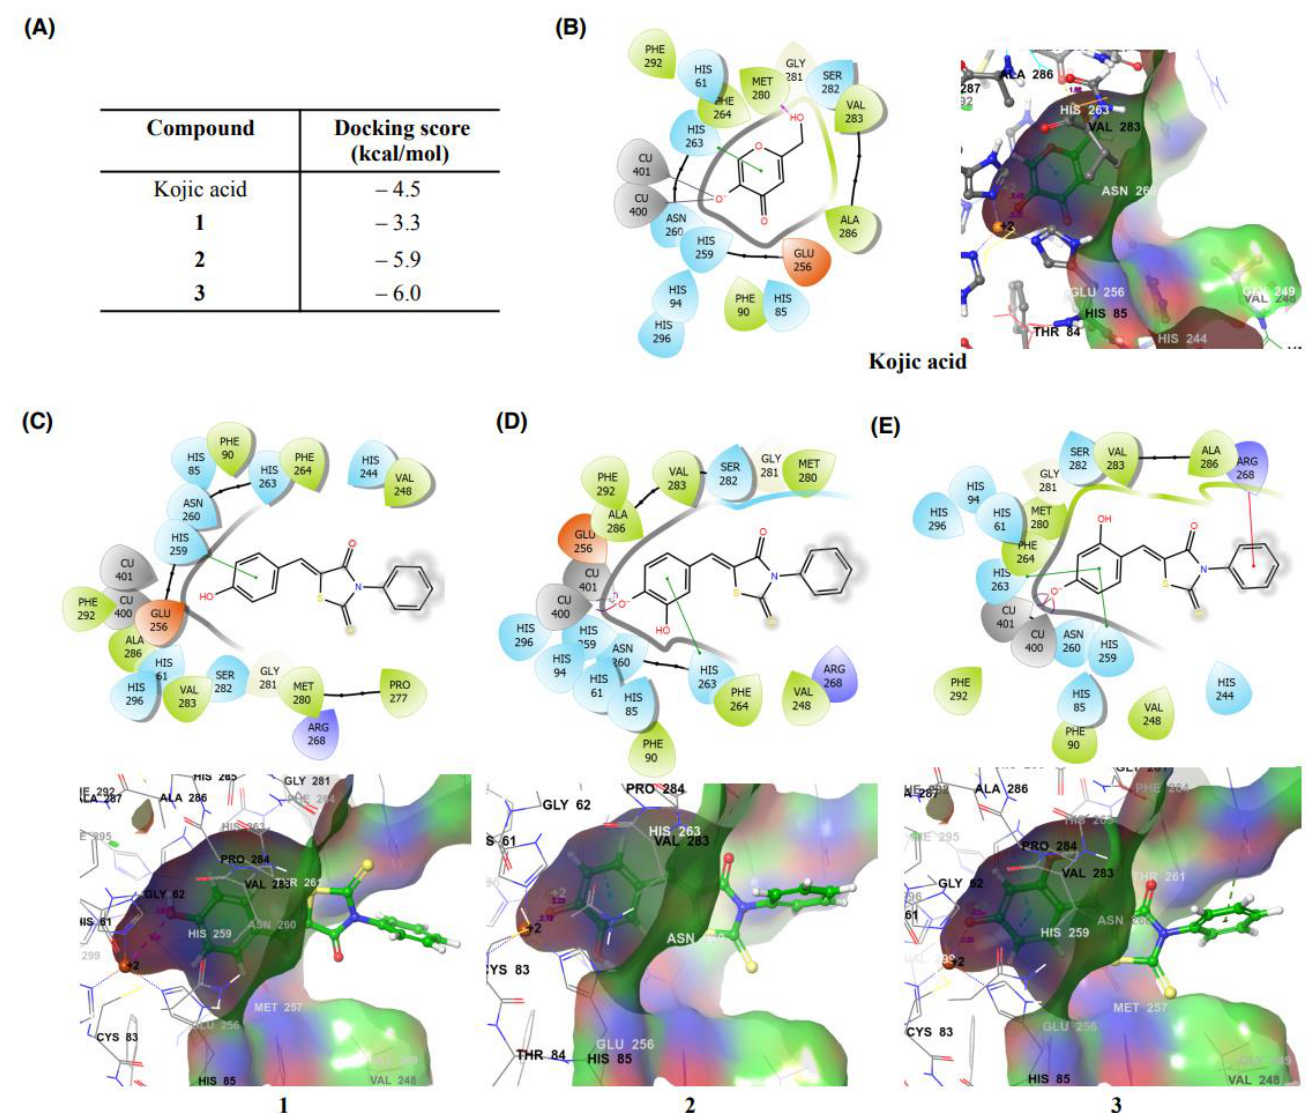
Figure 6. Docking scores ( A ) and expected binding interactions ( B – E ) of analogs 1 , 2 , 3 , and kojic acid as determined using the crystal structure of mushroom tyrosinase and Schrödinger Suite.